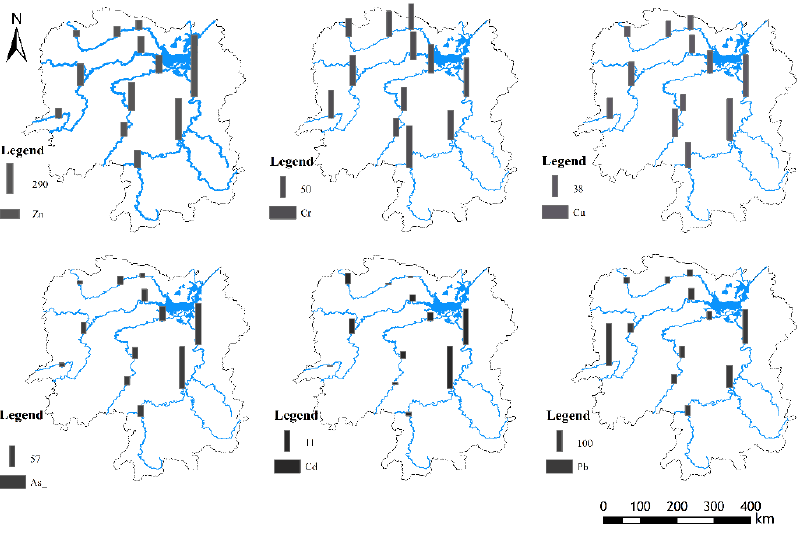
Figure 3. Heavy metal concentrations in different reaches of studied rivers (all metals in unit of